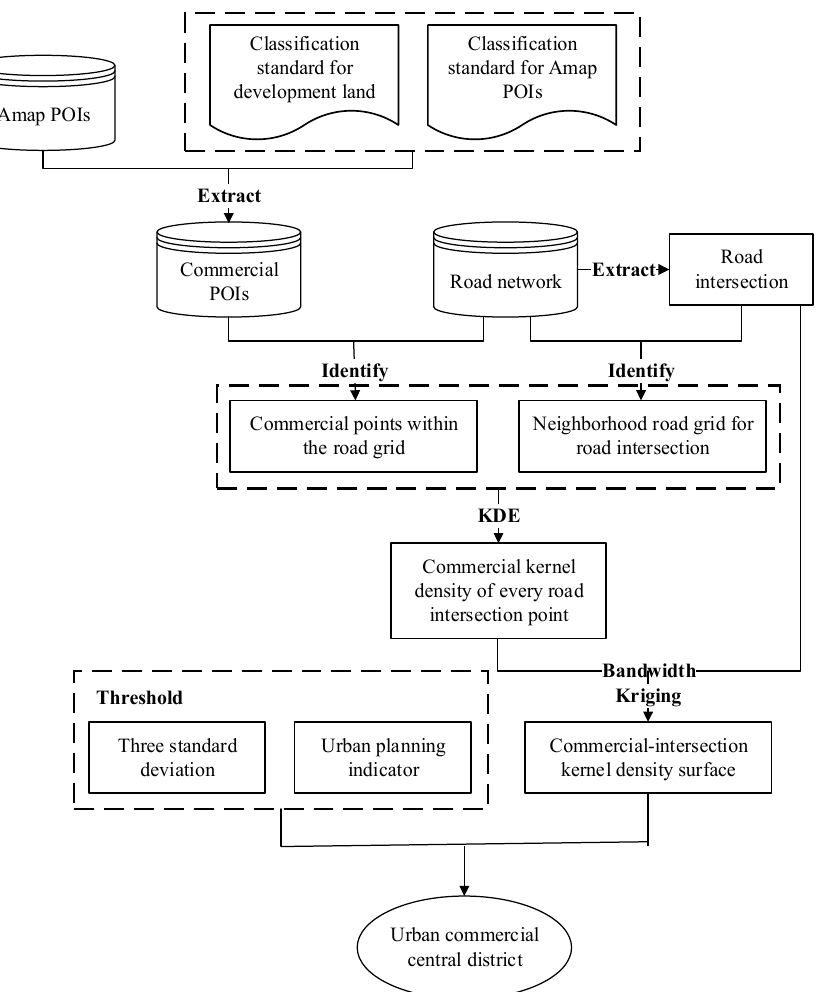
Figure 1. Overview of the procedure for delineating urban, commercial central districts. POI: point of interest; KDE: kernel density estimation.